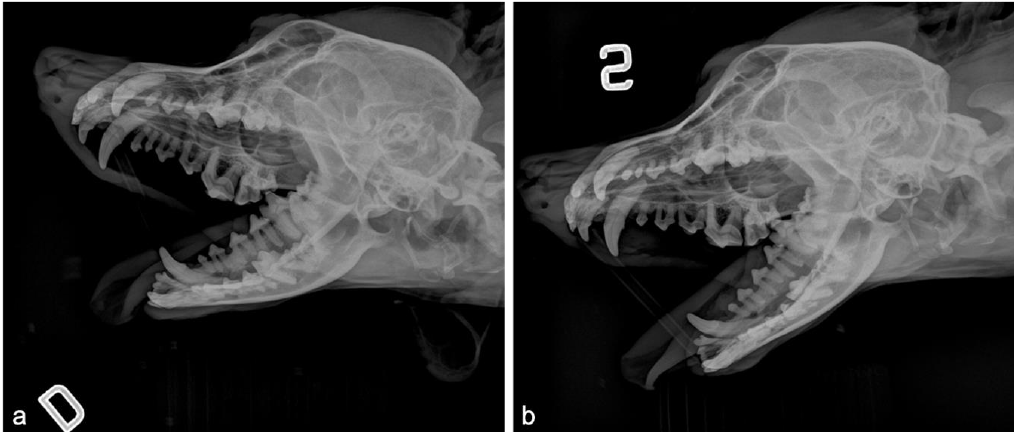
Figure 4. Pre-operative radiographic study: ( a ) oblique projections in the right lateral recumbency (D indicates the right lateral recumbency), left maxillary hemi-arch, and right mandibular hemi-arch are visible inside; ( b ) oblique projections in the left lateral recumbency (S indicates the left lateral recumbency), right maxillary hemi-arch, and left mandibular hemi-arch are visible inside.